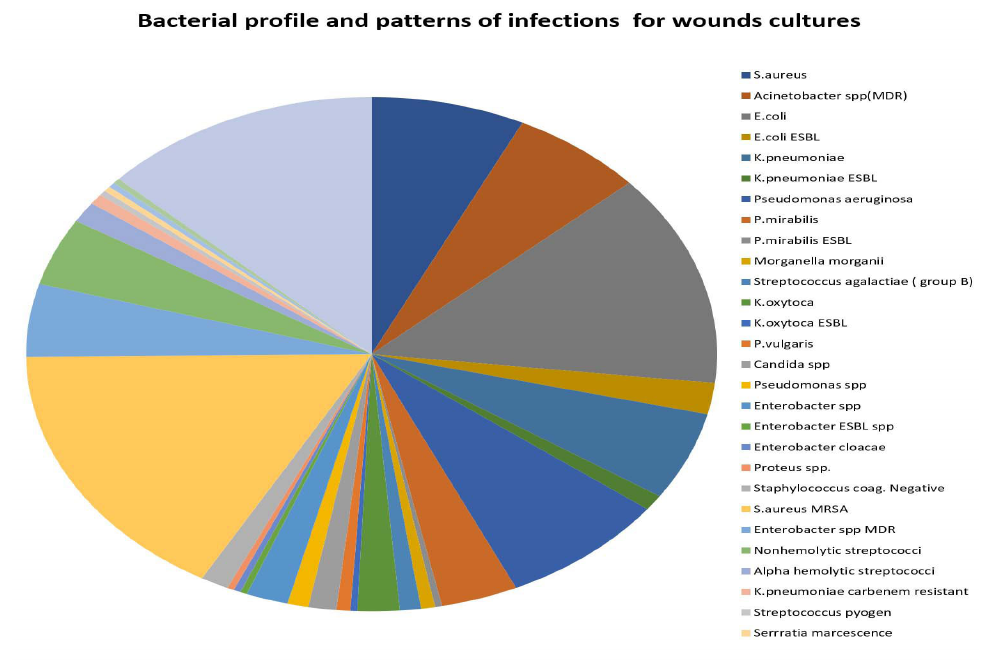
Fig. 4. Bacterial profile and patterns of infection for wounds